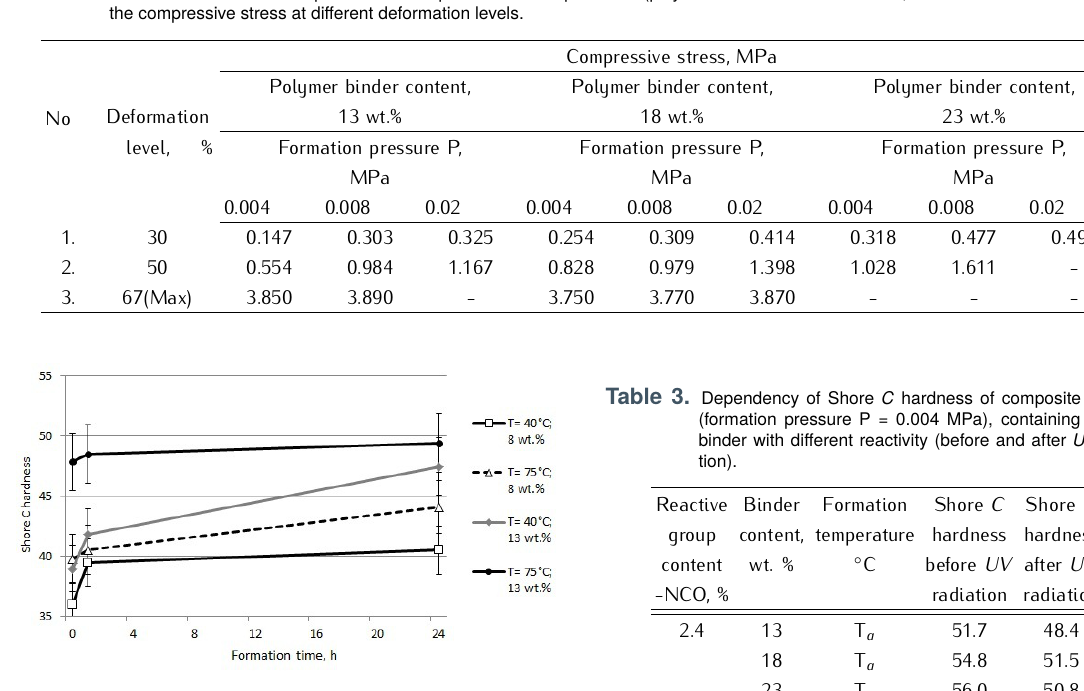
Figure 5. Influence of formation temperature on Shore C hardness ofcompositematerial(isocyanategroupcontent2.4%,for- mation pressure 0.004 MPa, binder content 8 wt.% and 13 wt.%, formation temperature T= 40 ◦ C (RH at 40 ◦C =8-12%) and T= 75 ◦ C (RH at 75 ◦ C = 4-6%).